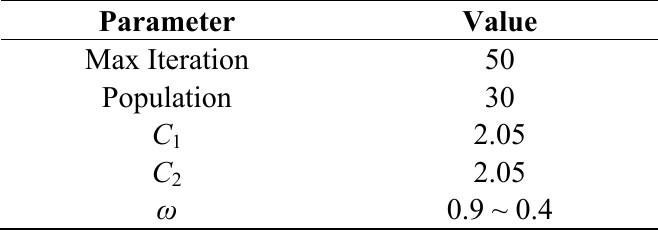
Table 3. Parameters of PSO